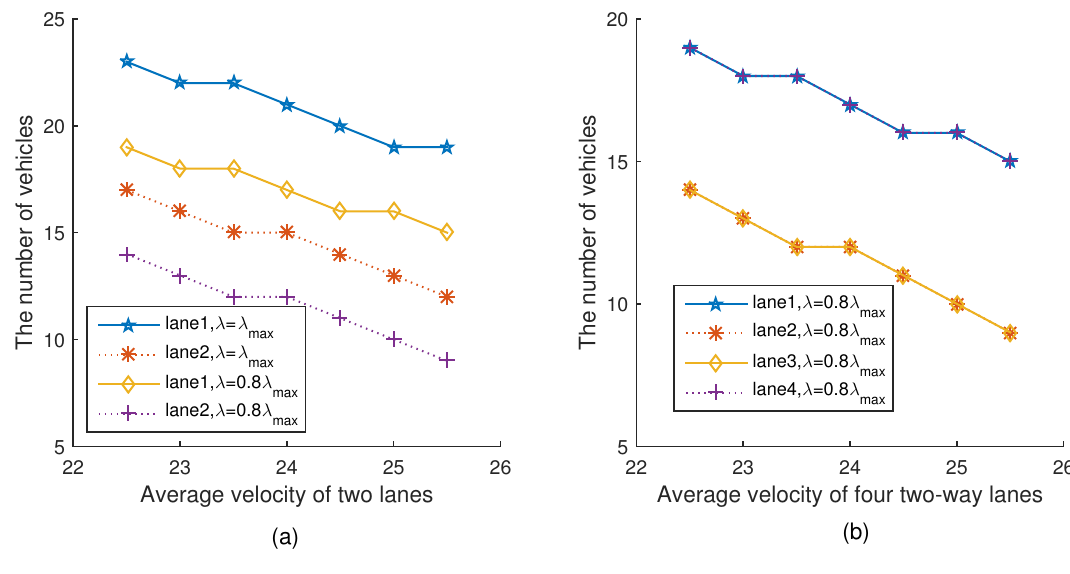
Figure 8. The number of vehicles versus velocity.